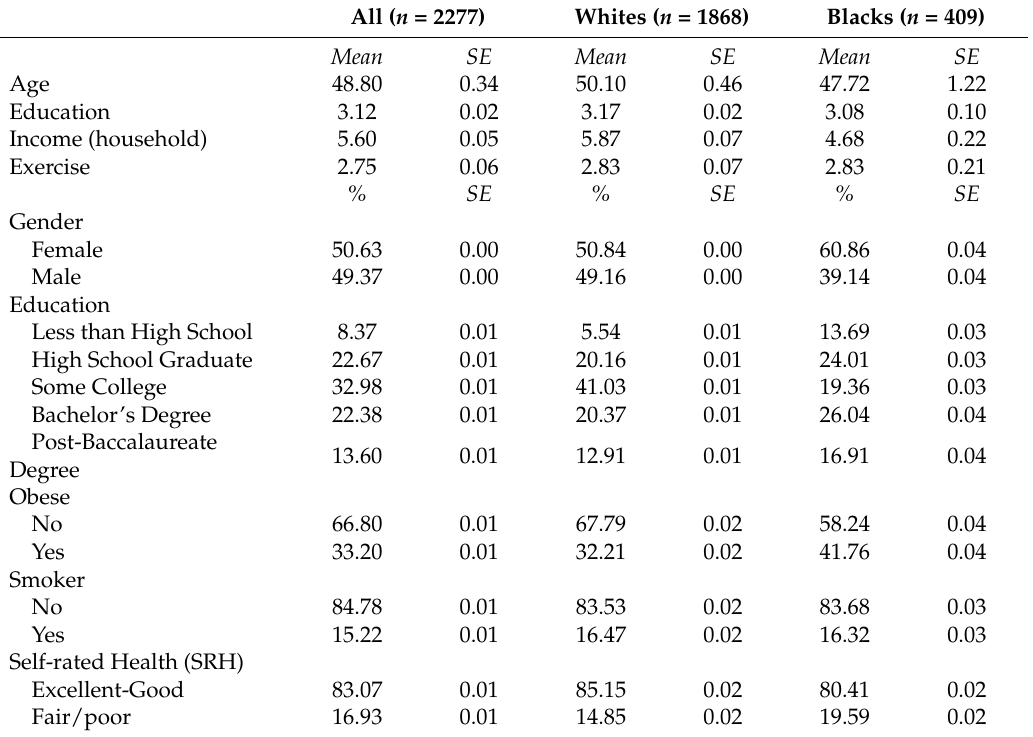
Table 1. Descriptive statistics in the overall sample and by